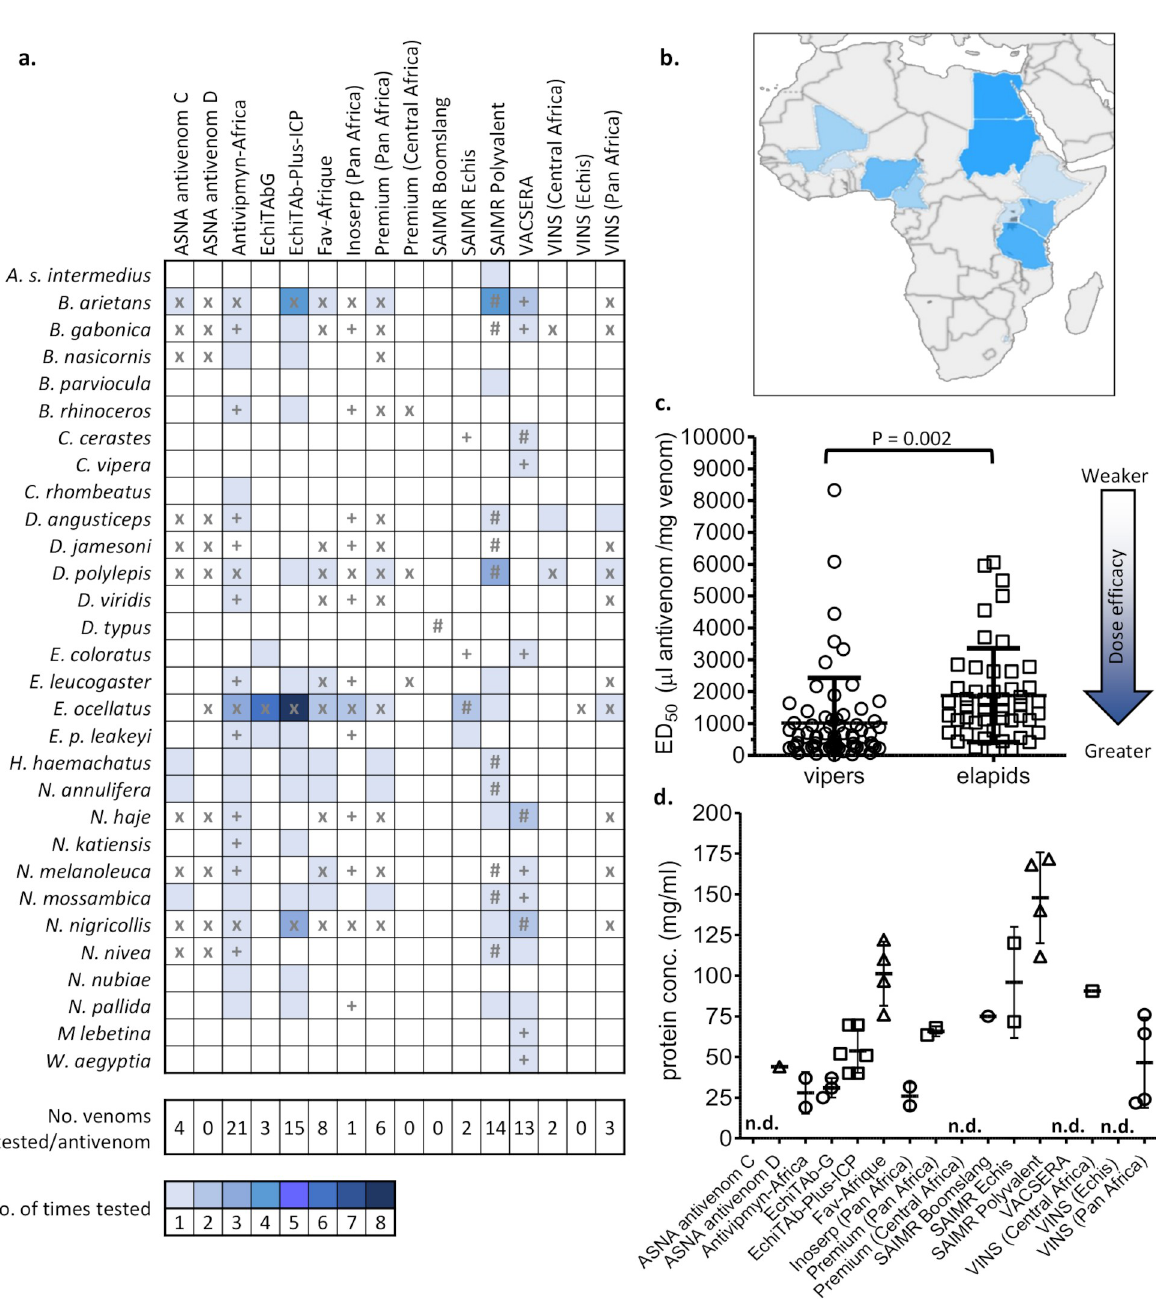
PLOS NeglectedTropical Diseases | https://doi.org/10.1371/journal.pntd.0008579 August 20, 2020 7 /